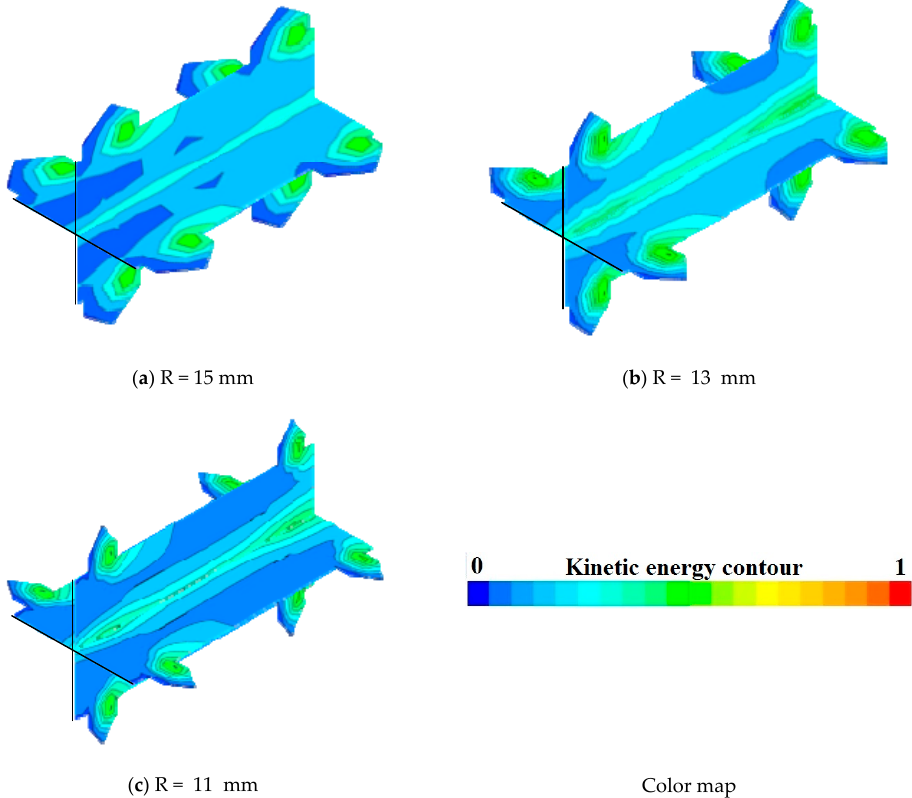
Figure 5. Temperature contours for various configurations of Case A with different R parameters at A 2 = 24 mm, Re = 15,000, and 𝜑 = 0.5%.